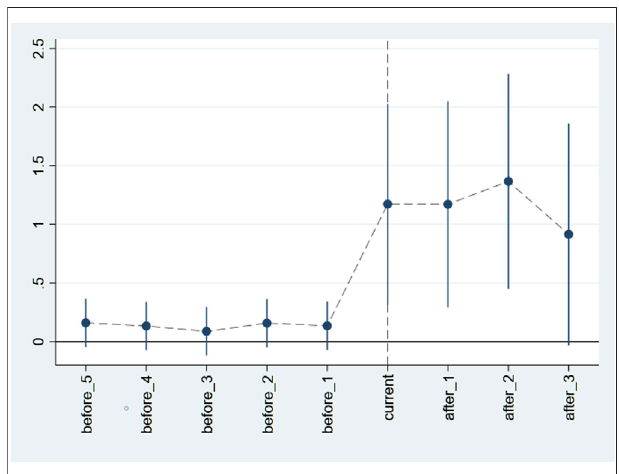
FIGURE 1 | Results of the parallel trend